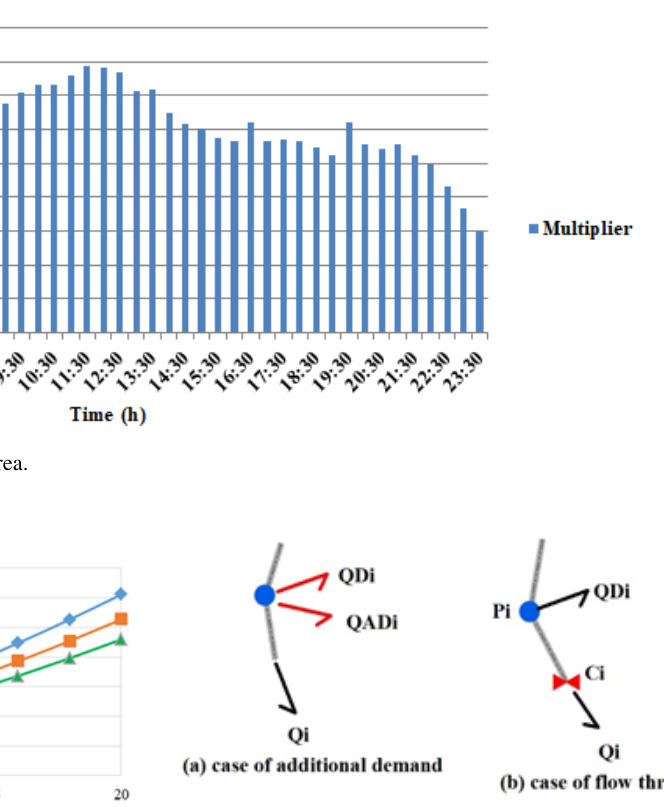
Figure 7. Ways to model a water leak in a hydraulic network model (Sebbagh et al.,